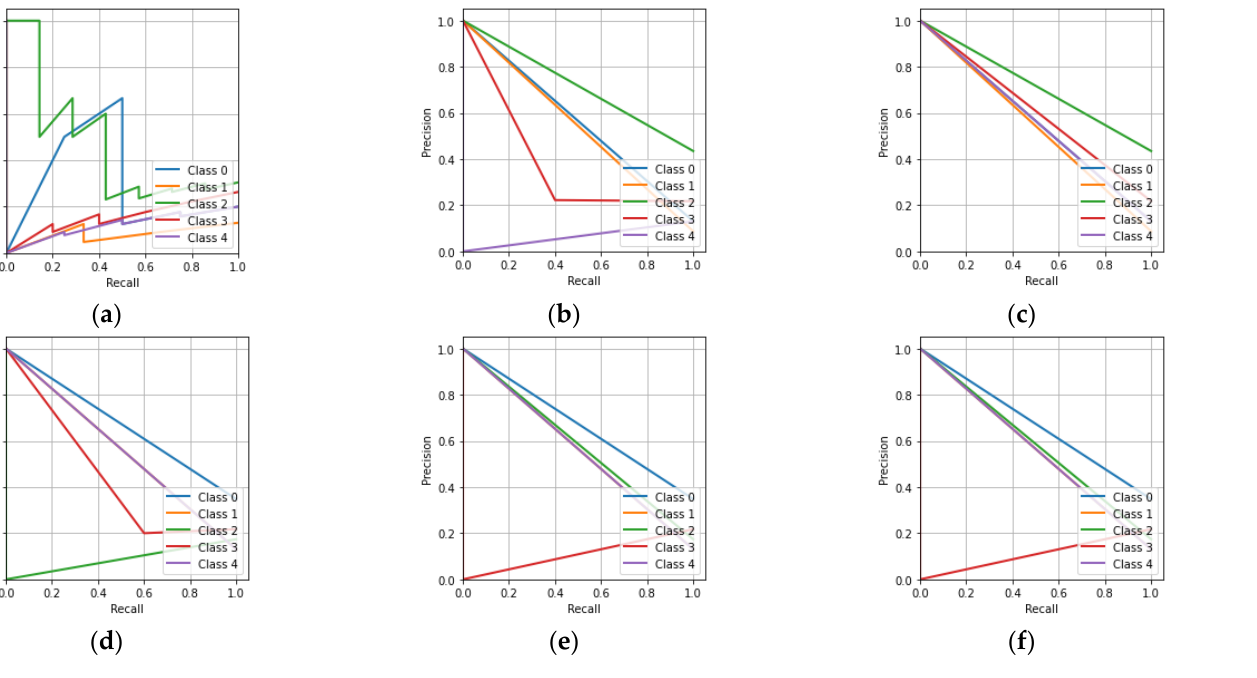
Figure 10. Precision-recall characteristics for the hologram dataset: ( a ) CNN; ( b ) KNN; ( c ) MLP; ( d ) DT; ( e ) RF; ( f ) ET.